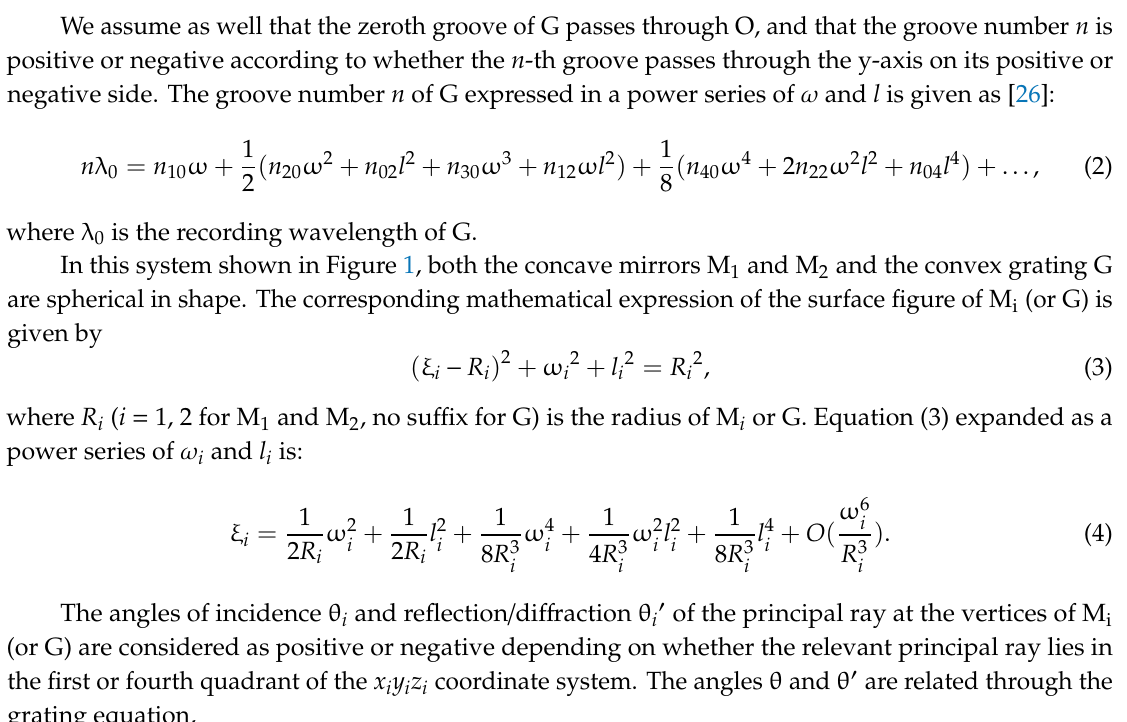
Figure 1. Schematic diagram of an Offner configuration and its coordinate systems.